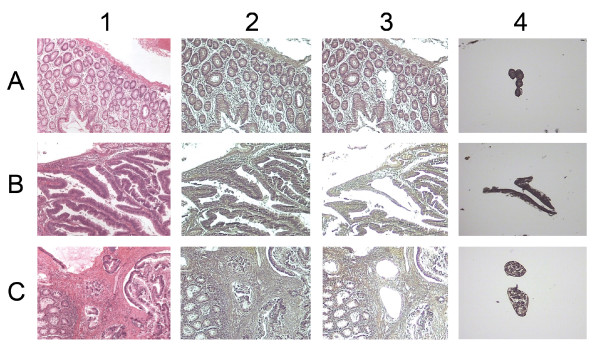
Laser capture microdissection of colorectal cells. A) normal; B) adenoma and C) carcinoma. 1) H&E-stained slide (× 20); 2) hematoxylin stained slide before LCM (× 20); 3) hematoxylin stained slide after LCM (× 20) and 4) cap showing adherent cells (× 20).